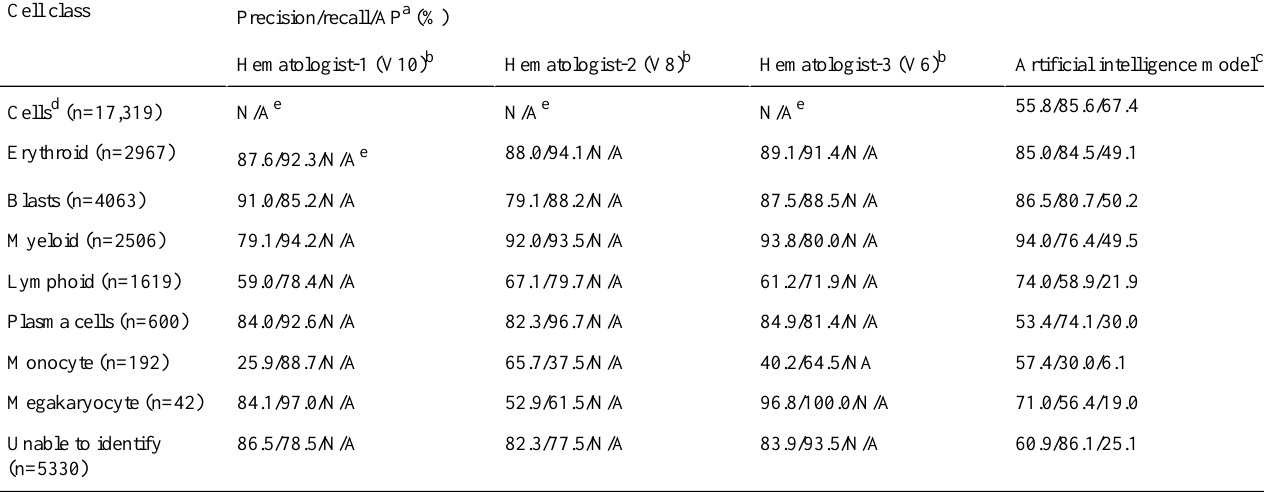
Table 3. Cell classification performances of hematologists and the deep learning model in the development cohort. Precision/recall/AP a (%)Cell